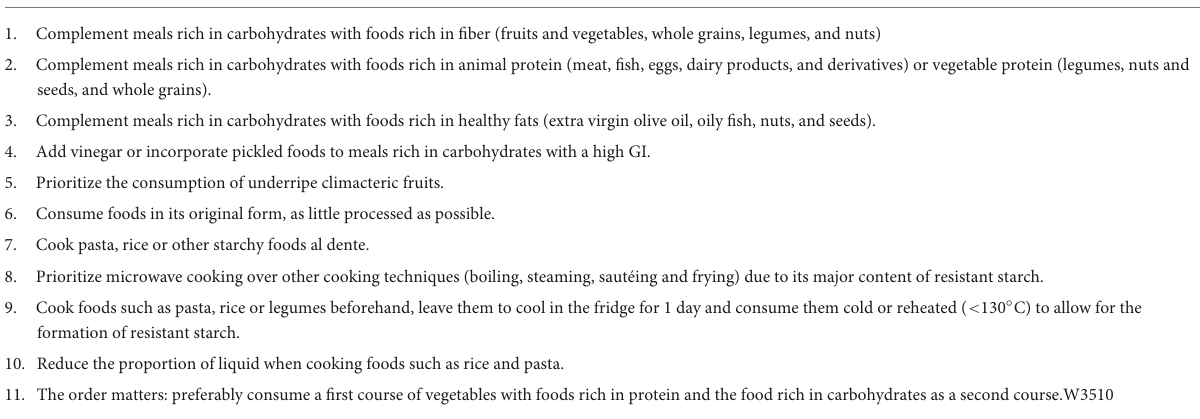
TABLE 2 Practical dietary recommendations for reducing postprandial glycemia in type 2 diabetes (T2D) when starchy foods are